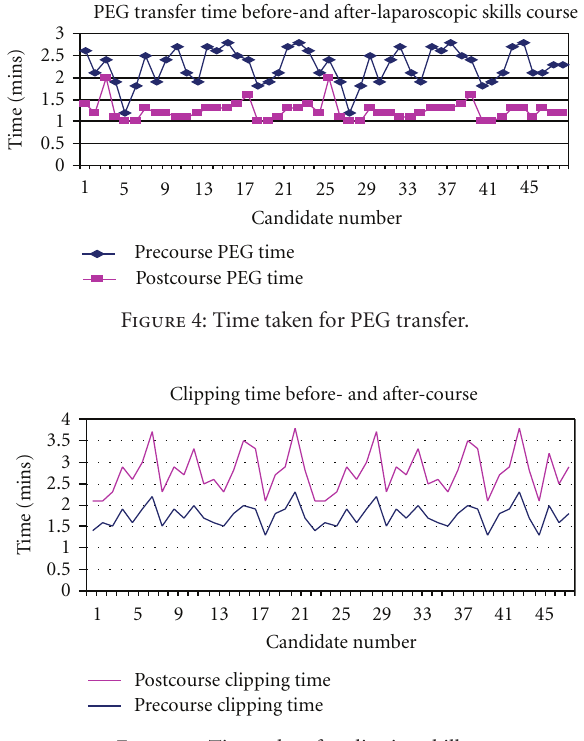
Figure 5: Time taken for clipping skills.